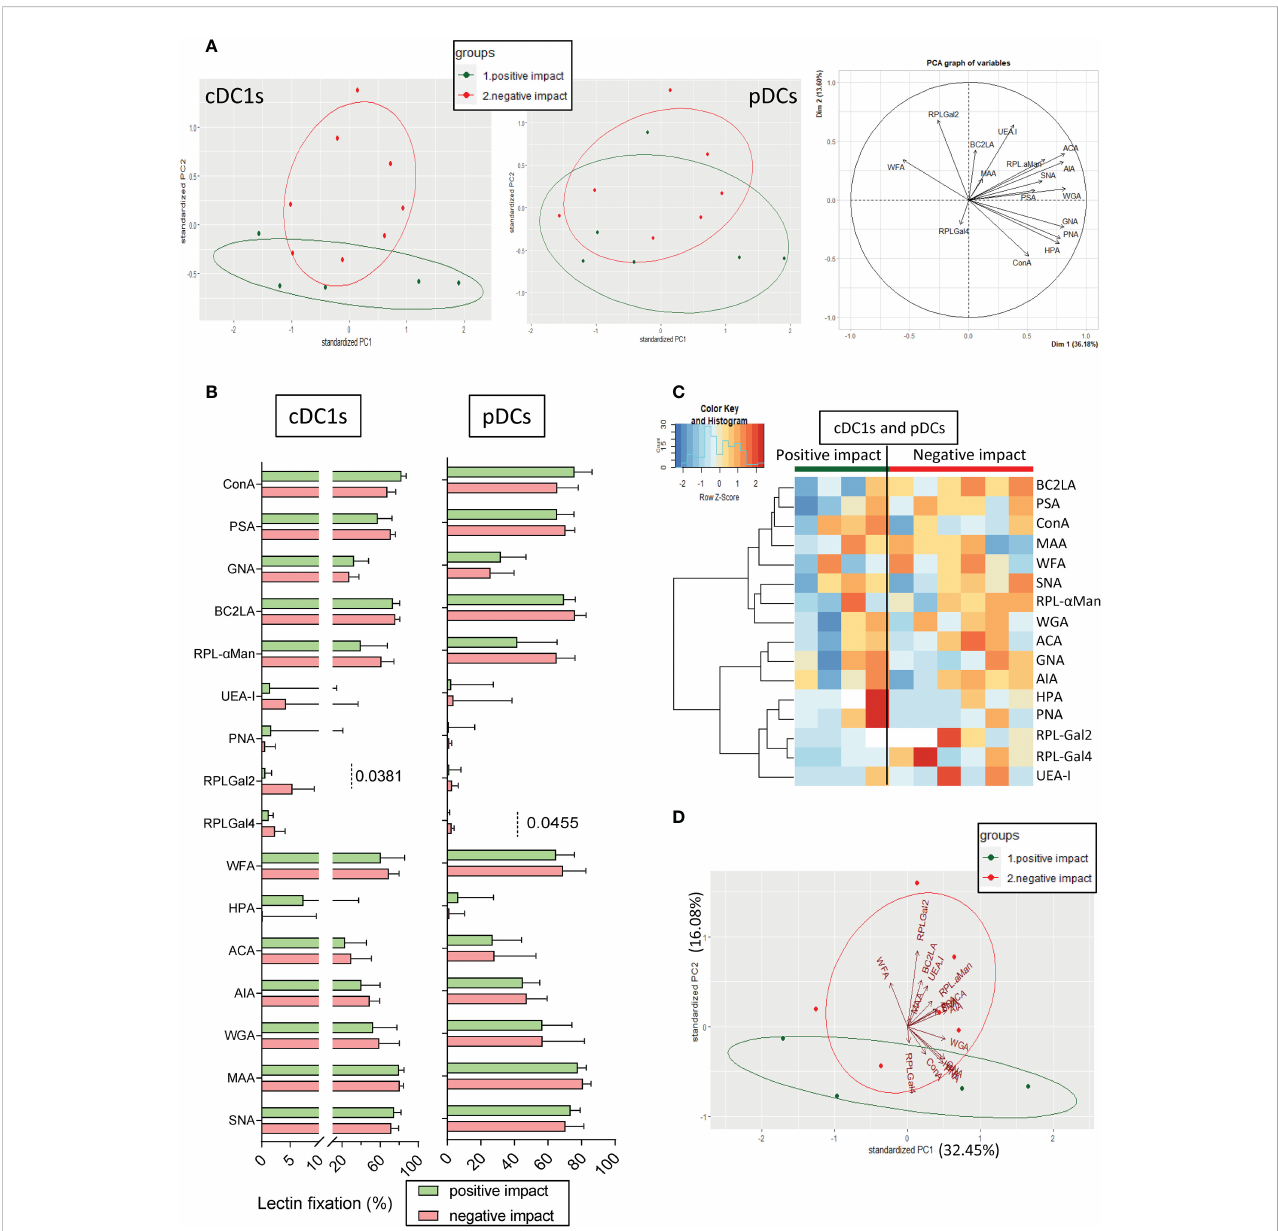
FIGURE 4 Tumor cell lines with positive or negative impacts on cDC1s and pDCs harbor differences in their glyco-code. Glycan expression by tumor cell lines derived from melanoma patients was assessed through lectin fi xation (GLYcoPROFILE ™ ). Samples were then grouped depending on their individual impact (positive or negative) on cDC1s and pDCs (groups de fi ned in Figure 1). (A) Principal component analysis (PCA) based on lectin fi xation of tumor cell lines derived from melanoma patients (including graph of variables; right panel). Tumor cells were separated given their positive or negative impact on cytokine production by cDC1s (left panel) and pDCs (middle panel) (n = 5 to 8 tumors per group). (B) Frequencies of lectin fi xation (indicators of glycan expression levels) by tumor cells which positively or negatively impacted cytokine production by cDC1s or pDCs (n = 5 to 8 per group). Results are expressed as percentages of lectin binding within each group. Interleaved bars representation plotting median with interquartile range. Only signi fi cant statistics are shown on graphs. P -values were calculated using Mann-Whitney non parametric test. (C) Heat map based on frequencies of fi xation of 16 different lectins (binding different glycans) on tumor cell lines that positively (n = 4) or negatively (n = 6) impacted cytokine production by cDC1s and pDCs. (D) PCA based on lectin fi xation by tumor cells separated given their positive or negative impact on cDC1s and pDCs (n = 4 to 6 per